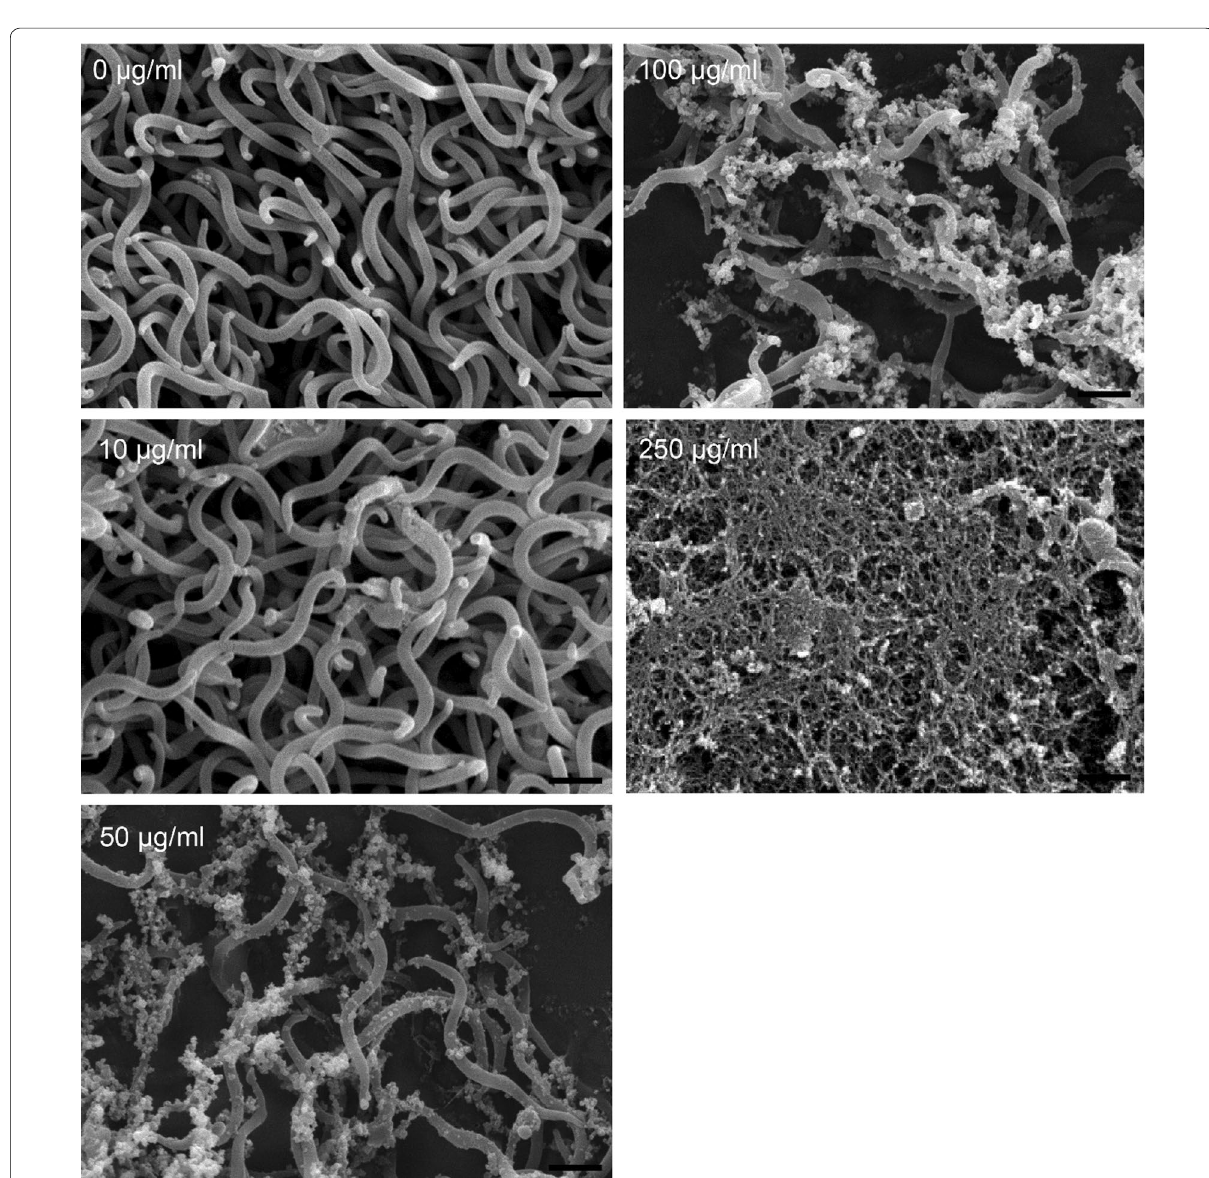
Fig. 4 Scanning electron microscope images of B. hyodysenteriae illustrating the antibacterial activity of different concentrations (10, 50, 100, 250 μg/ml) of the commercial surfactin after incubating for 1 h. Three experiments were conducted, and one representative result is